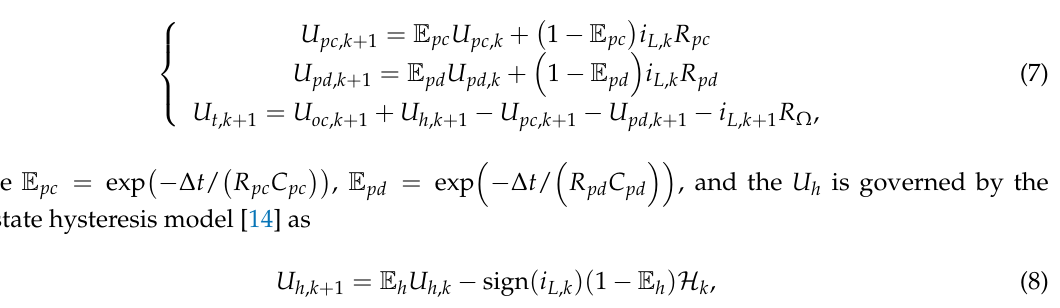
Figure 5. Second-order equivalent circuit model.